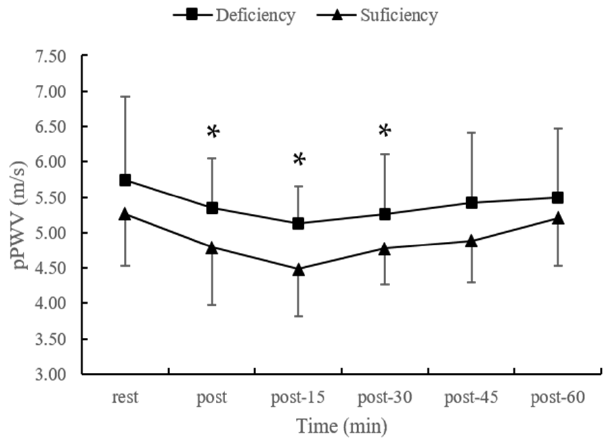
Figure 1. The changes in pPWV following acute maximal exercise in different vitamin D status. Abbreviations: pPWV, peripheral pulse wave velocity. * p < 0.05 Significant differences between sufficiency and deficiency group.